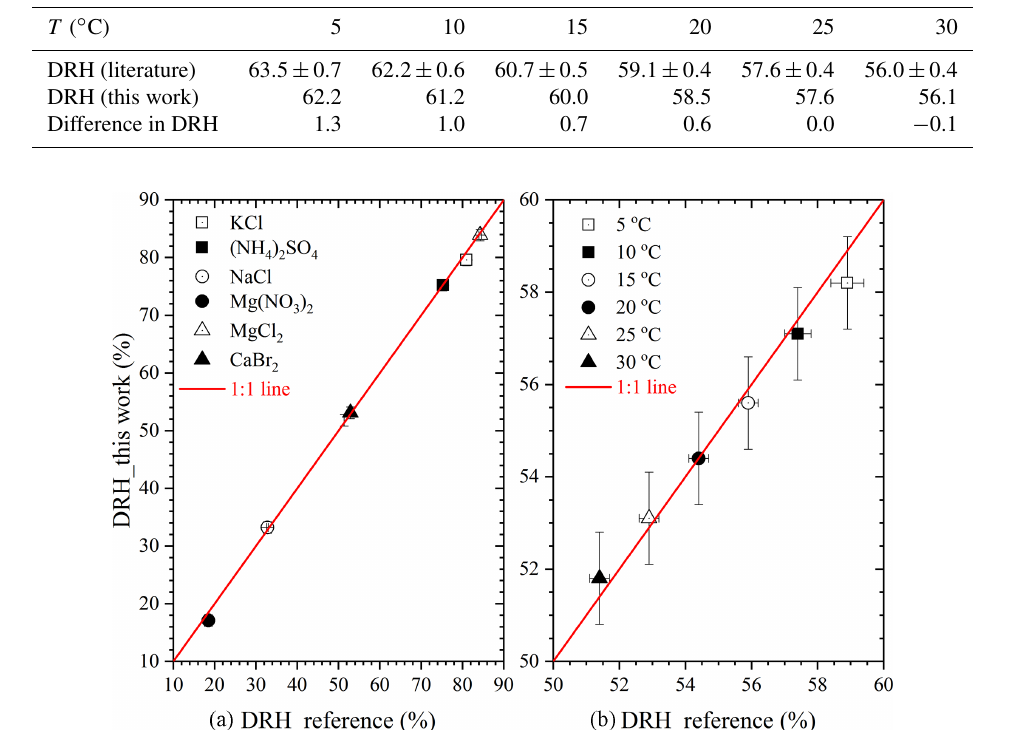
Table 1. Comparison of DRHs (in %) of NaBr at different temperatures measured in our study with those reported in literature (Greenspan, 1977). The uncertainties for our measured DRH values are estimated to be ± 1%.